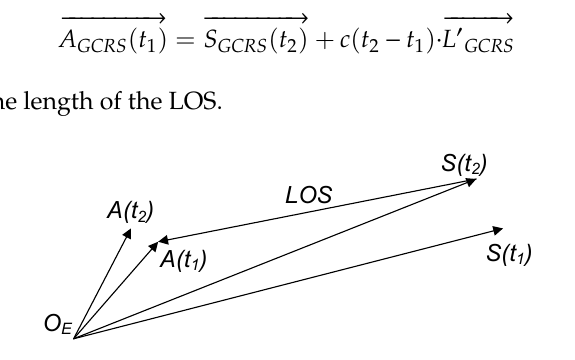
Figure 3. The spatial relation in the Geocentric Celestial Reference System (GCRS).